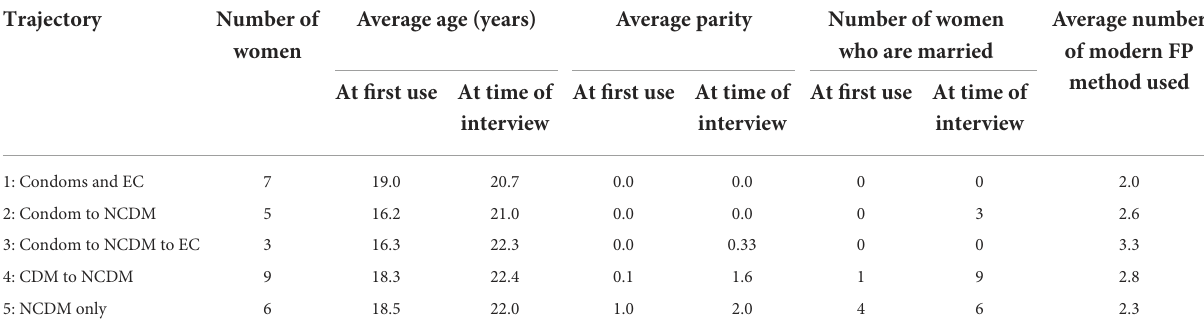
TABLE 2 Characteristics of respondents in each trajectory. Trajectory Number of